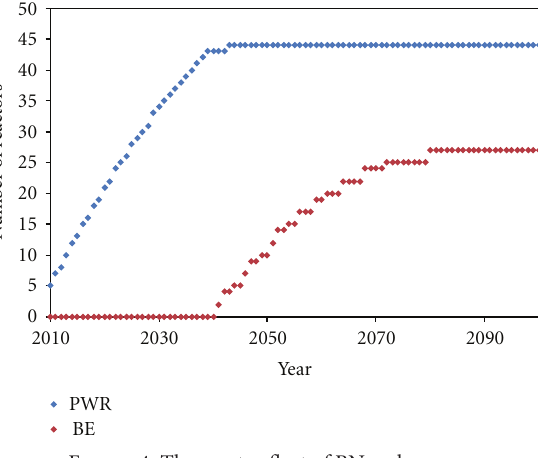
Figure 3: The reactor fleet of OT.